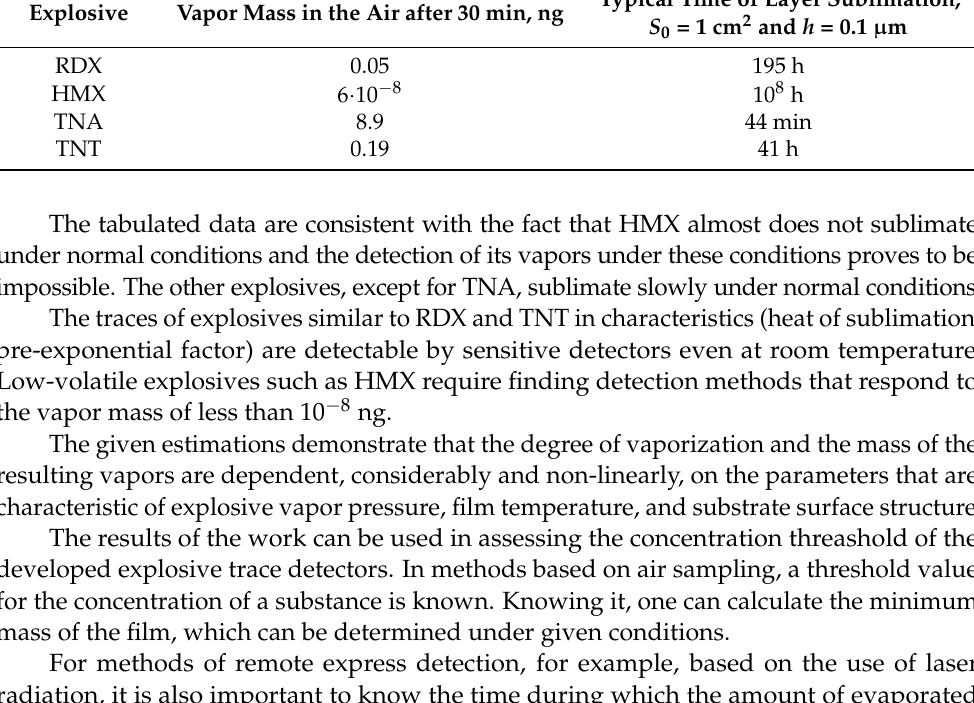
Table 2. Calculated sublimation behaviors of the explosives at T = 293